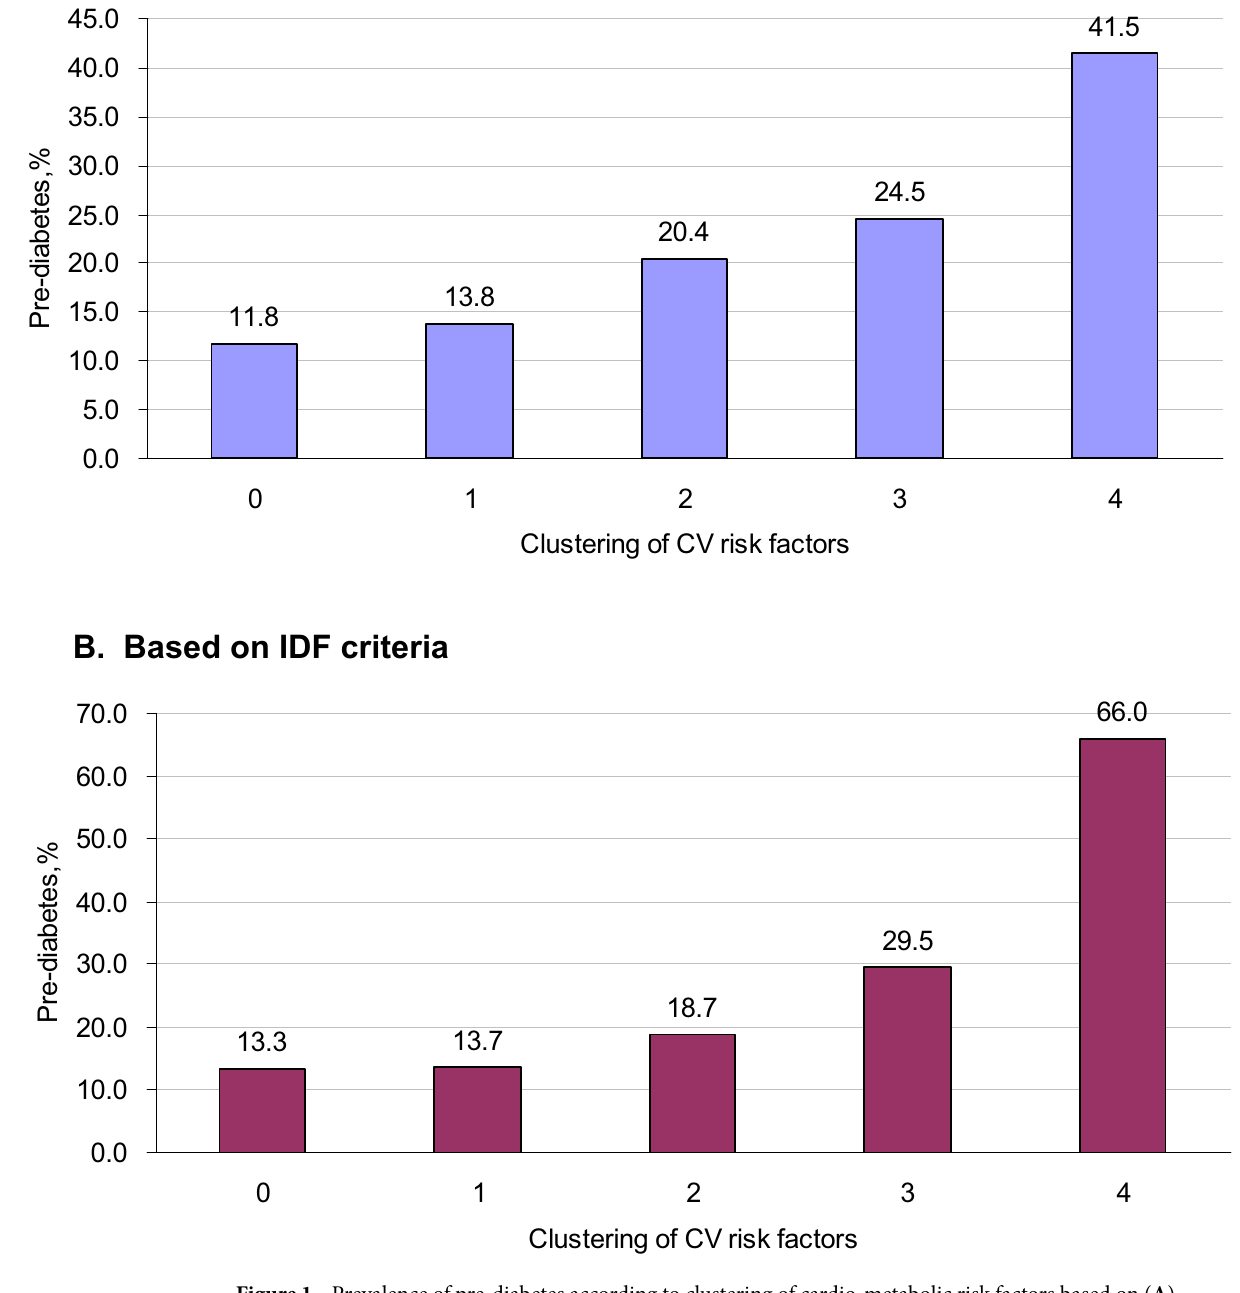
Figure 1. Prevalence of pre-diabetes according to clustering of cardio-metabolic risk factors based on ( A ) NCEP criteria and ( B ) IDF